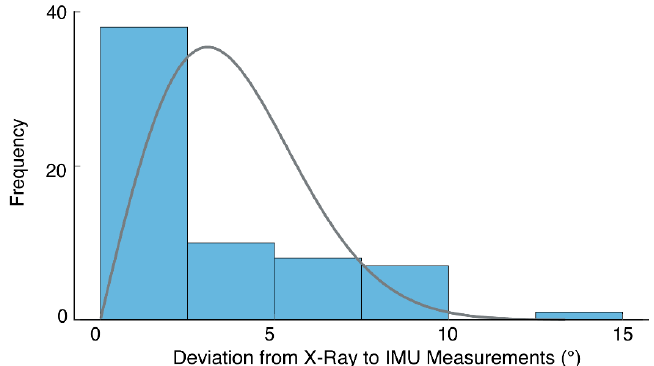
Figure 6. A histogram of absolute errors (shaded bars) based on both FS and SU positions (i.e., 64 measurements in total). The results suggest errors follow a Poisson distribution (solid line), with a skew towards lower values.